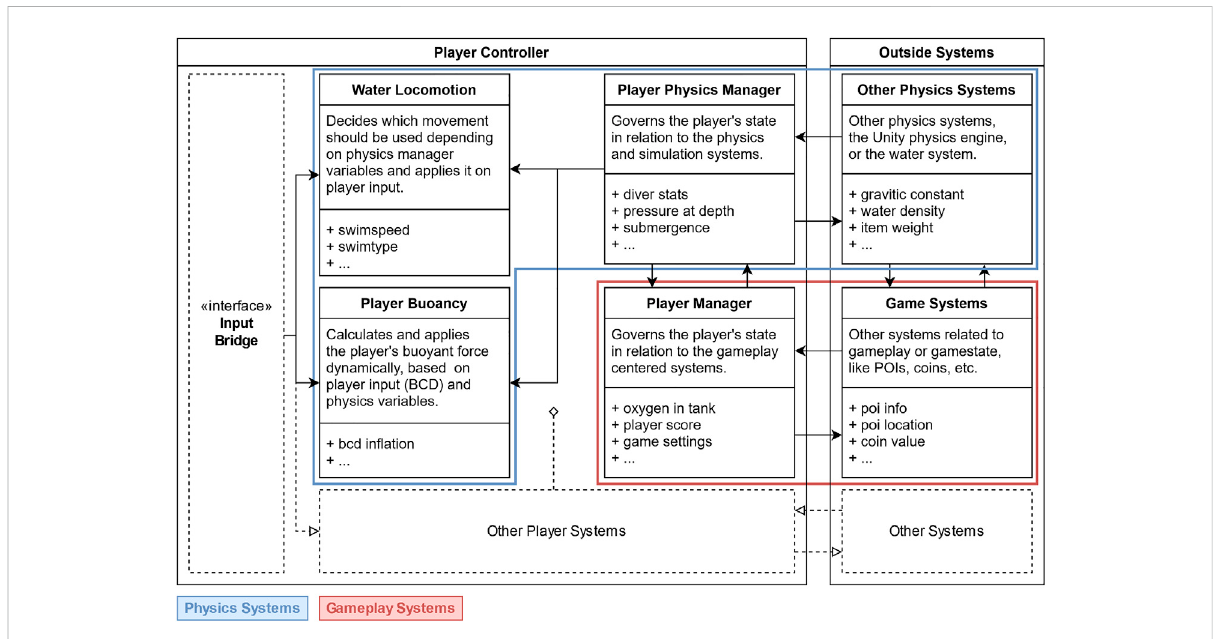
FIGURE 1 Simpli fi ed overview of the different subsystems withing the player